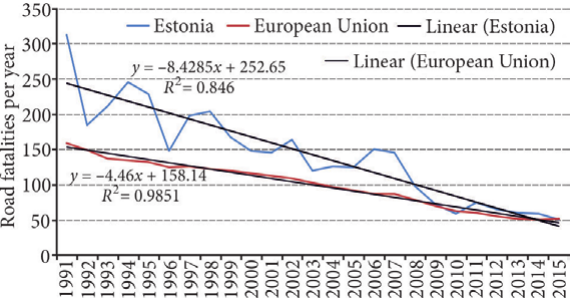
Fig. 1. Road accident fatalities per million population in Estonia and the European Union (1991–2015)